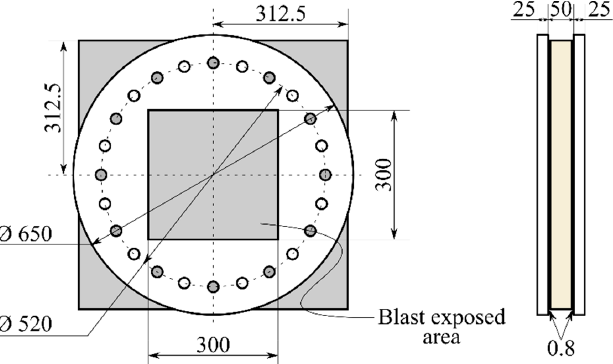
Figure 7. Sketch of the test specimen and clamping frame. All dimensions in mm.